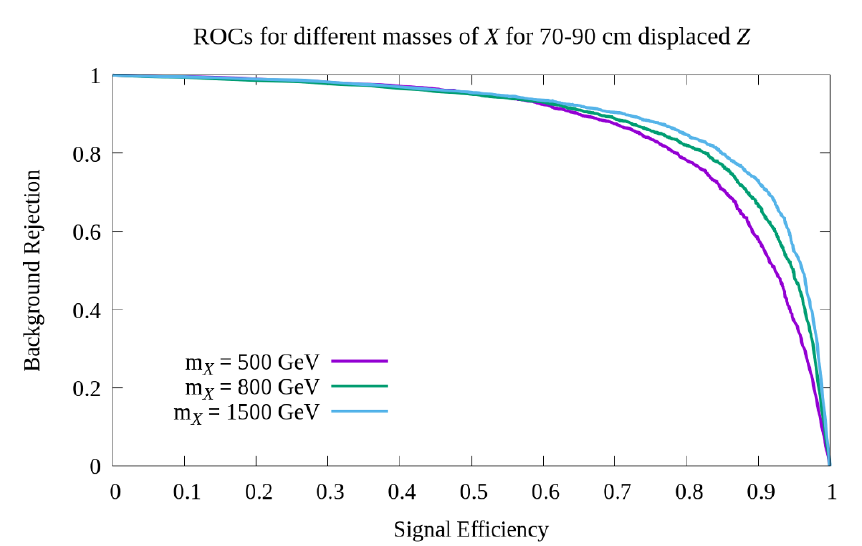
Figure 10. ROCs of the CNN performance to separate non-displaced Z from 70 cm (cid:0) 90 cm displaced Z for di(cid:11)erent masses of X